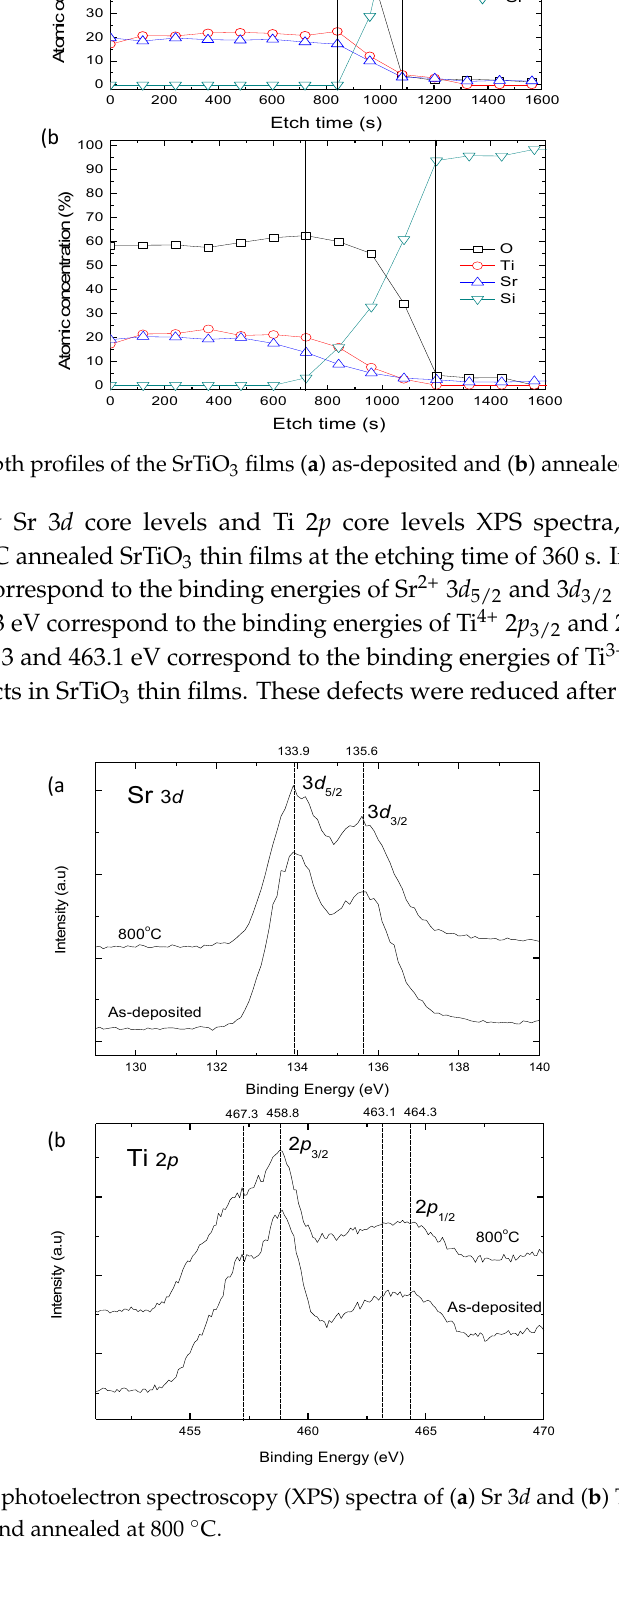
Figure 4. The X-ray photoelectron spectroscopy (XPS) spectra of ( a ) Sr 3 d and ( b ) Ti 2 p in the SrTiO 3 films as-deposited and annealed at 800 °C.